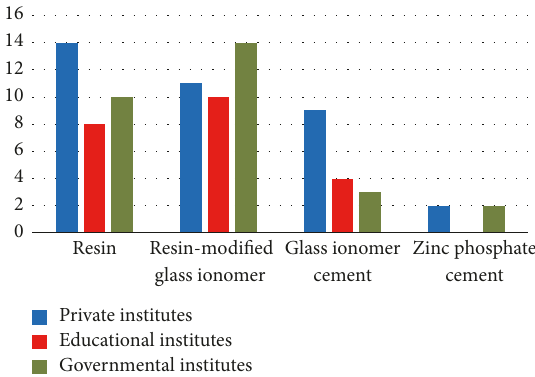
Figure 6: Definitive cementation material for the final implant restorations.